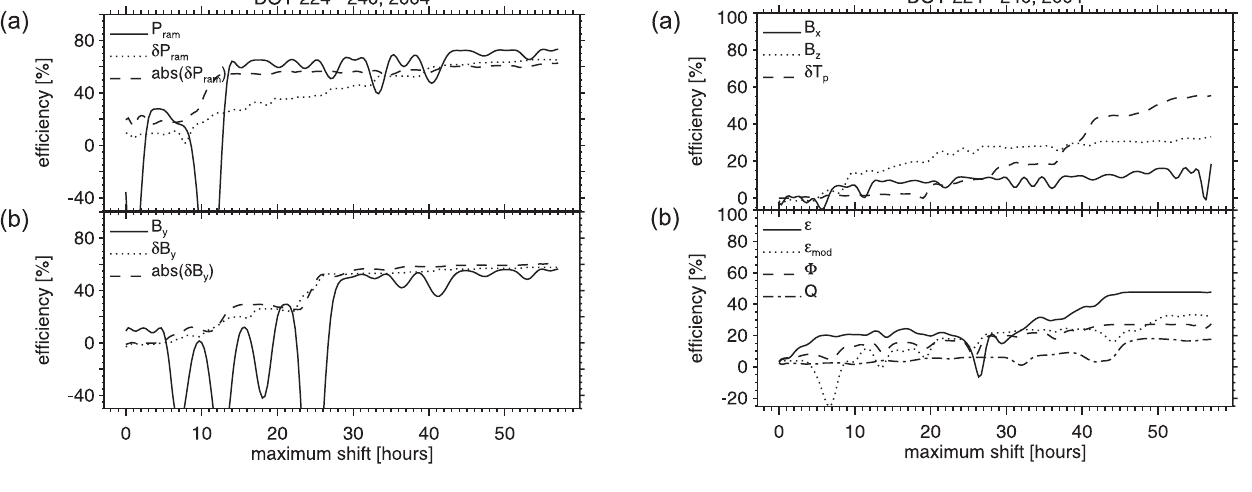
Fig. 4. Efficiency functions for (a) the ram pressure P ram and (b) the B y -component of the IMF in combination with SKR intensity as output signal for the time period DOY 224–240, 2004. The re- spective time derivatives of the inputs are flagged with δ and the absolute time derivatives are flagged with abs(δ) .